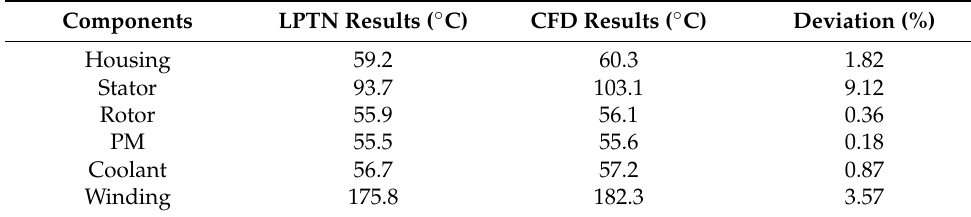
Table 6. Comparison of temperature calculation results under 796 r/min @ 200 kW.